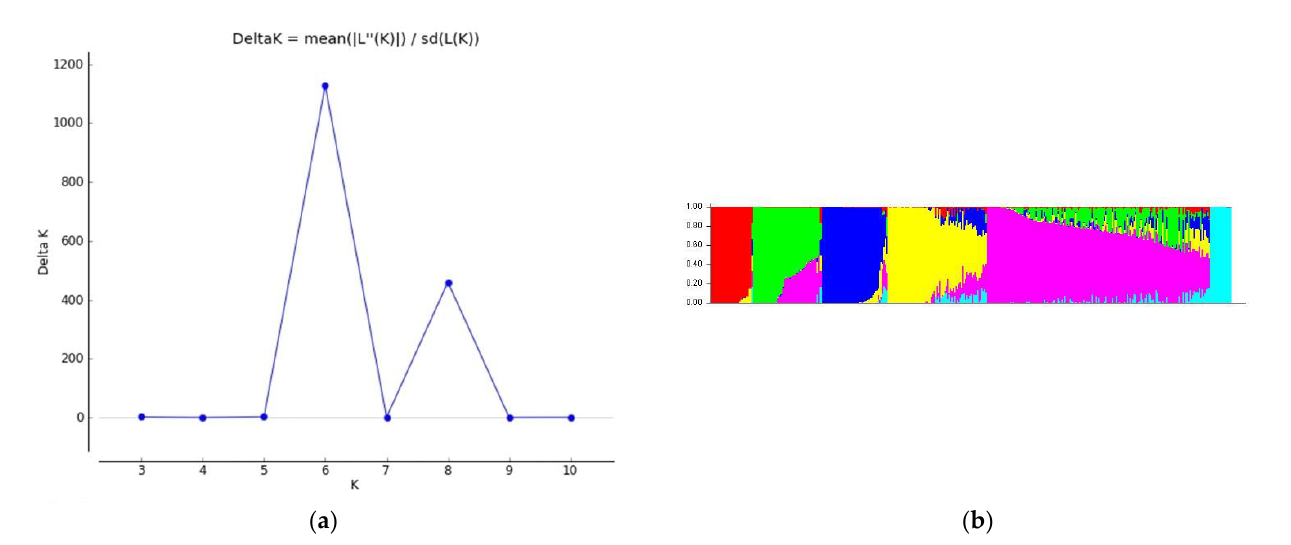
Figure 1. ( a ) Evaluation of STRUCTURE outputs; ( b ) estimated population structure. ( a ) The change in log probability of ΔK value (K) ; ( b ) the estimations of population structure at K = 6 for 400 inbred lines. Each inbred line is represented as a vertical segment, which is partitioned into 6 colored segments to denote estimated membership to the K cluster. Table 1. Trait performance across